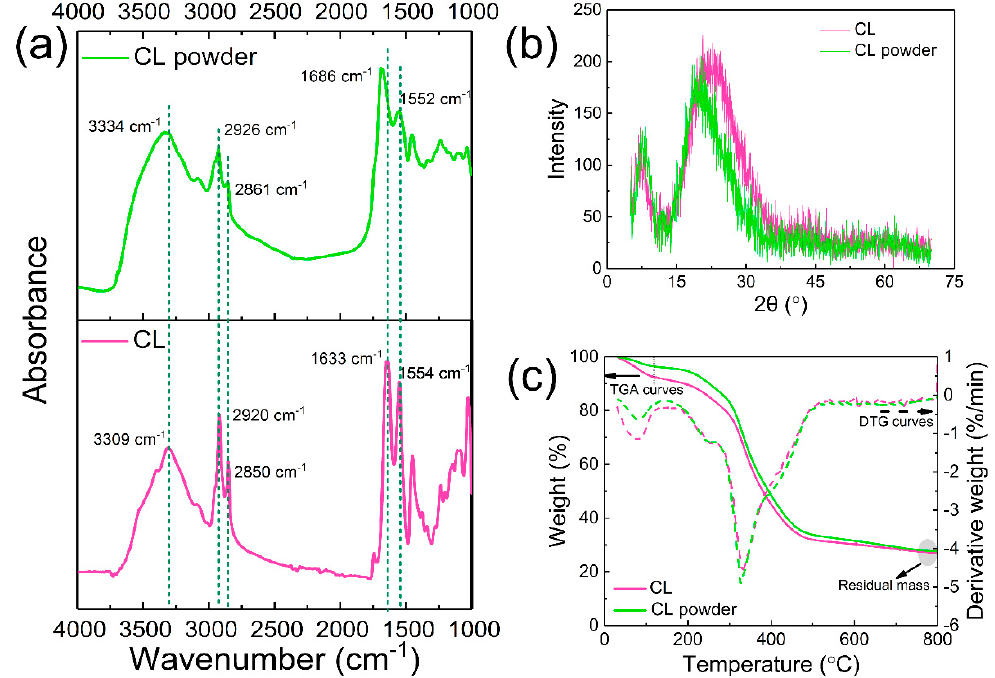
Figure 5. ( a ) FTIR spectra of CL and CL powder; ( b ) XRD curves of CL and CL powder; ( c ) TGA (left) and DTG (right) curves of CL and CL powder.